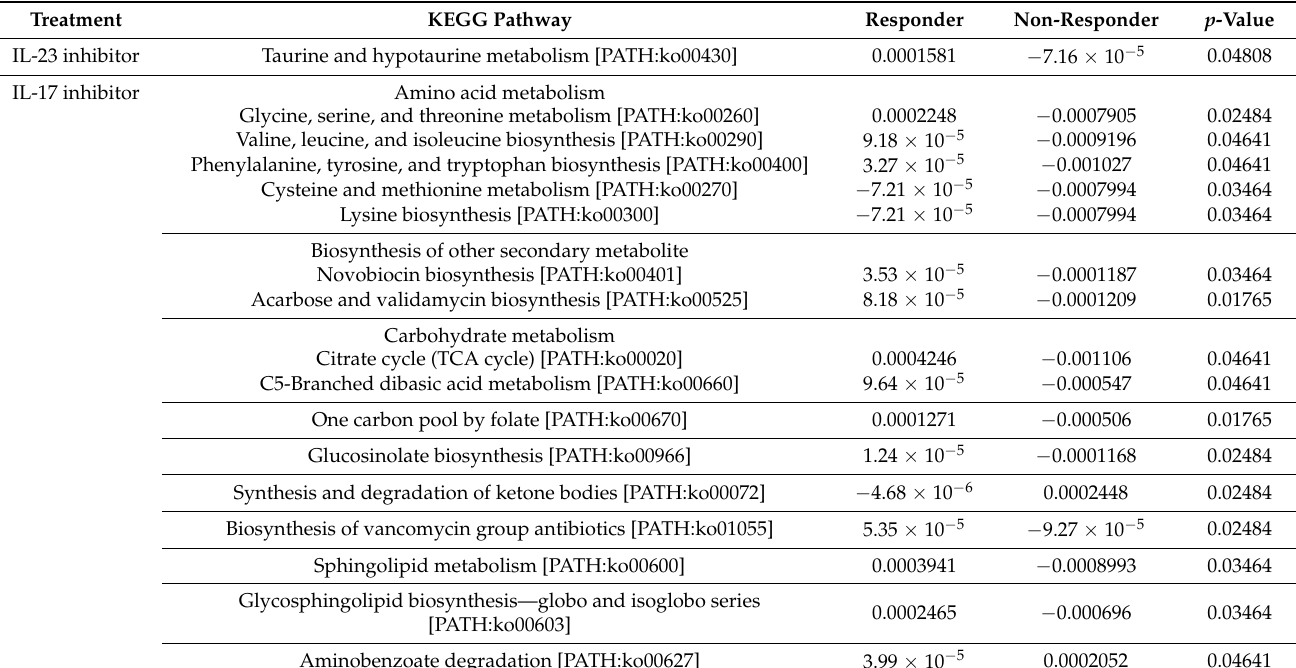
Table 3. Comparison of difference in abundance of KEGG metabolism pathways from the baseline to week 24 post-treatment between responders and